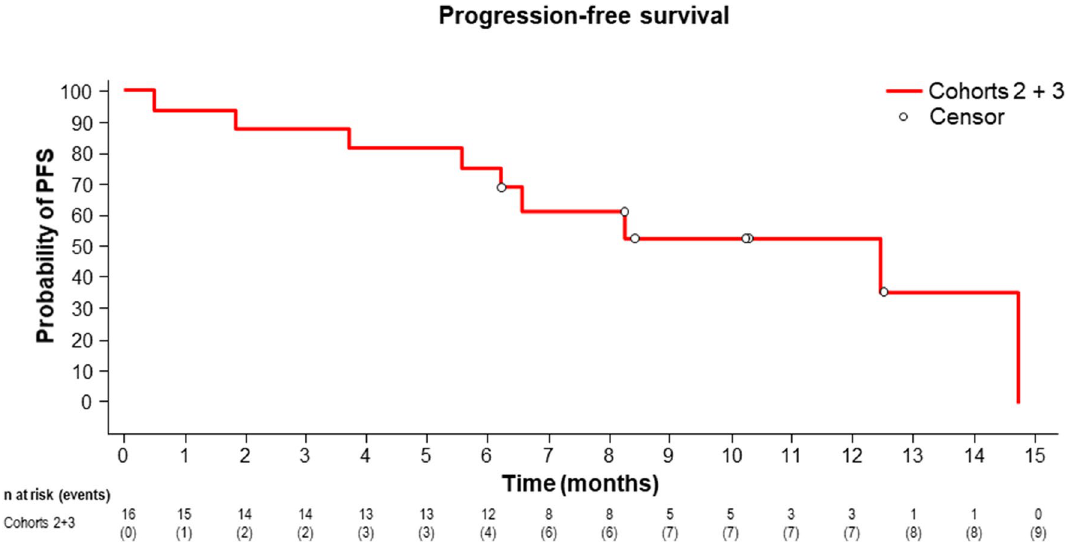
Figure 1. Kaplan–Meier curve of PFS when cohorts 2 and 3 were combined. Kaplan–Meier curve was estimated from cut-off data of December 2018. The median PFS was 12.5 months (90% CI 5.6–14.7).